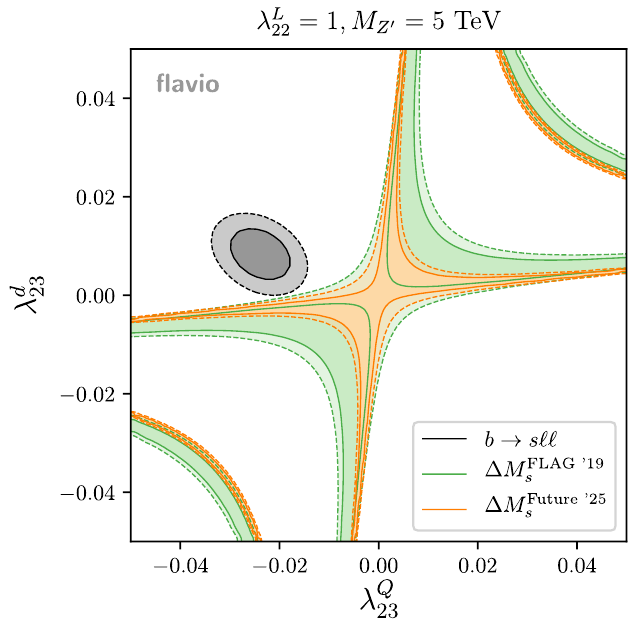
Figure 7 . Allowed regions at 1 (cid:27) (solid) and 2 (cid:27) (dashed) for b ! s‘‘ (grey) and (cid:1) M (FLAG ’19) and orange (Future